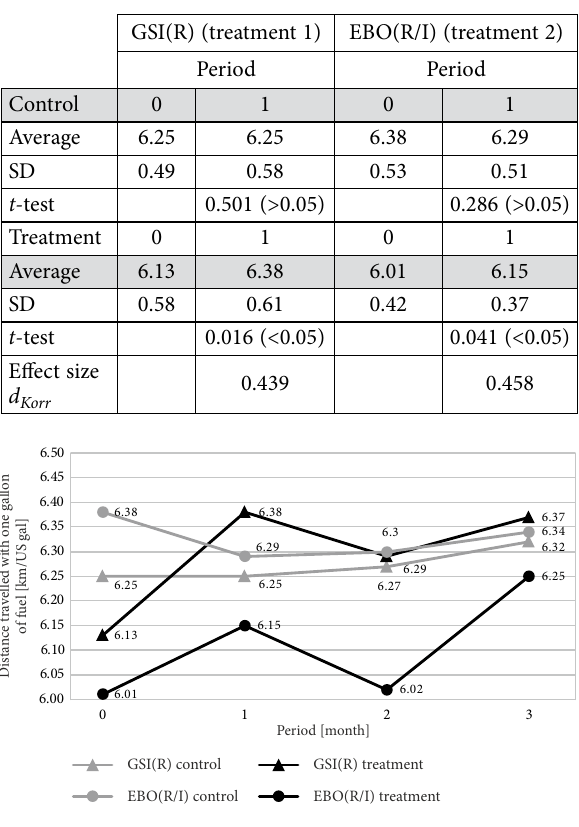
Figure 4. Distance travelled with one gallon of fuel for periods 0 (baseline) and months 1, 2 and 3